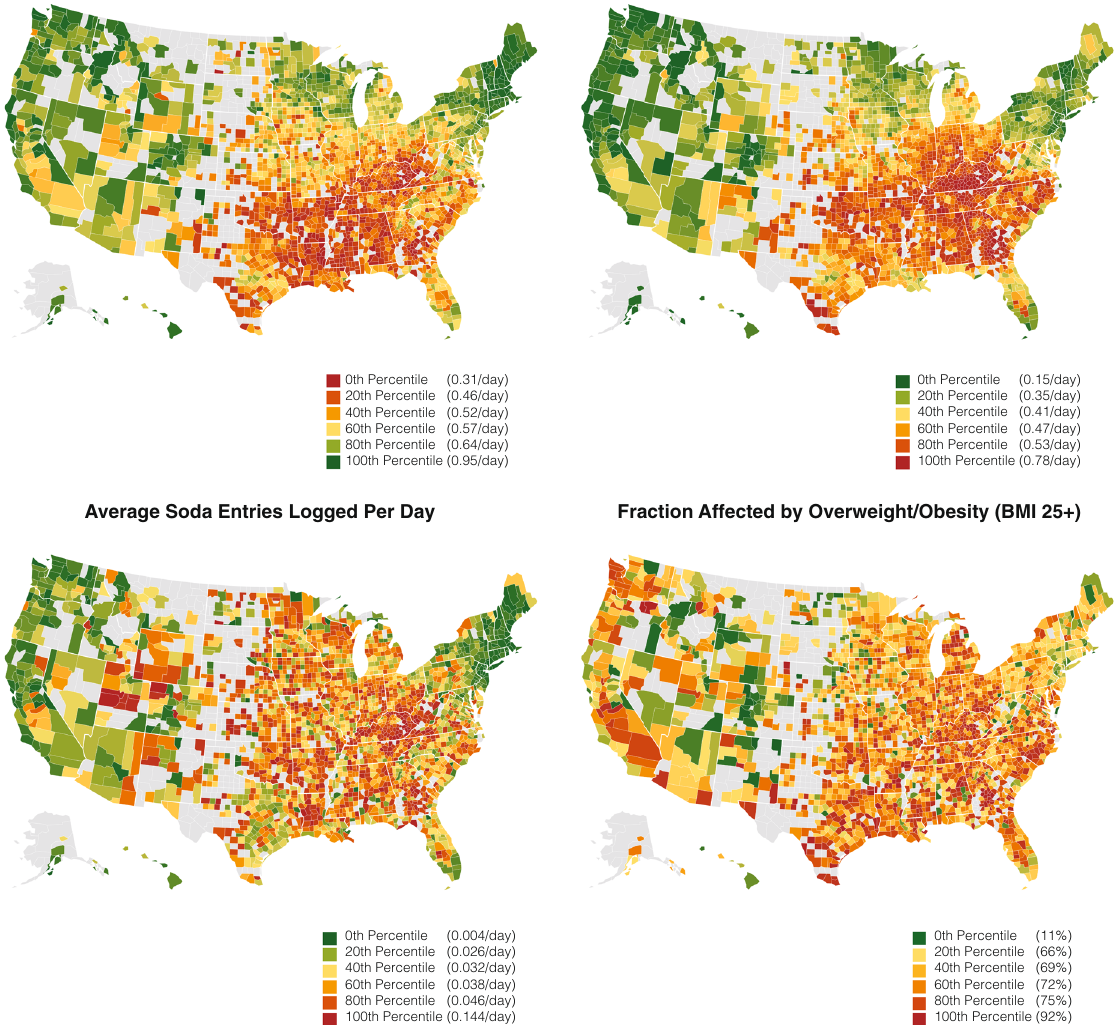
Fig. 2 Dietary consumption and BMI status across U.S. counties. A set of choropleths showing the main study outcomes of the number of entries that are classi fi ed as fresh fruit and vegetables, fast food, and soda consumption as well as the fraction affected by overweight/obesity (BMI > 25) participants across the USA by counties with more than 30 participants. We observe that food consumption healthfulness varies signi fi cantly across counties in the